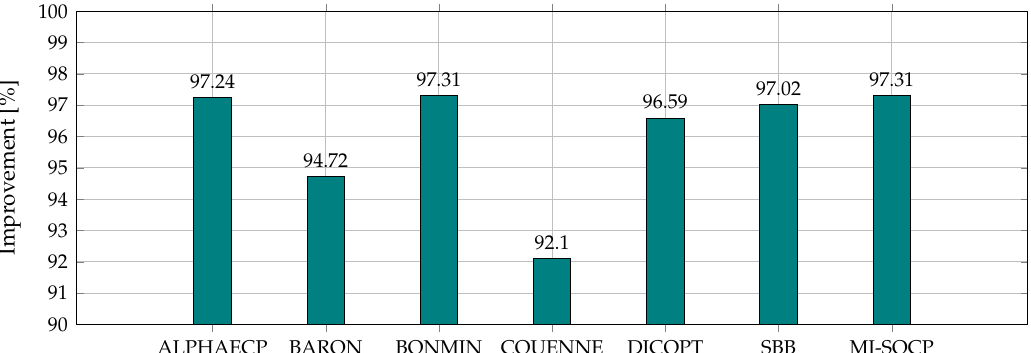
Figure 5. Improvement of the power losses using GAMS solvers and the proposed MI-SOCP